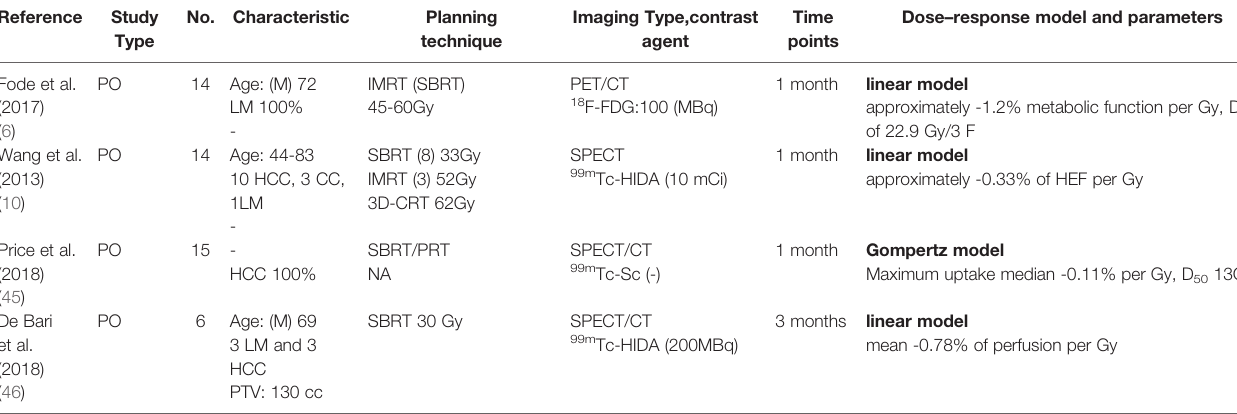
TABLE 3 | Description of dose – response relationship after